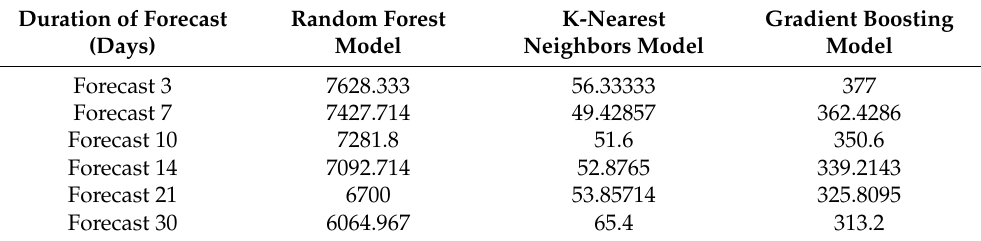
Table 6. Mean absolute error of forecasted cumulative new cases for Japan (number of cases).